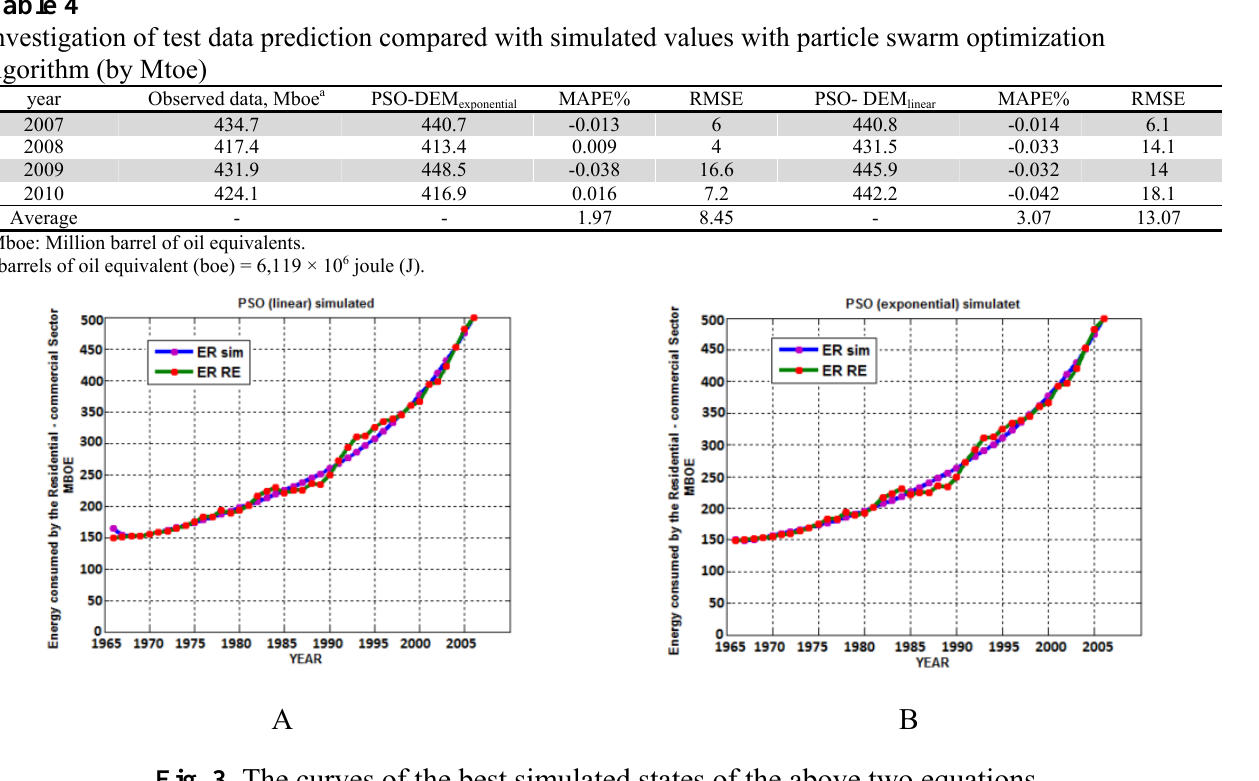
Fig. 3. The curves of the best simulated states of the above two